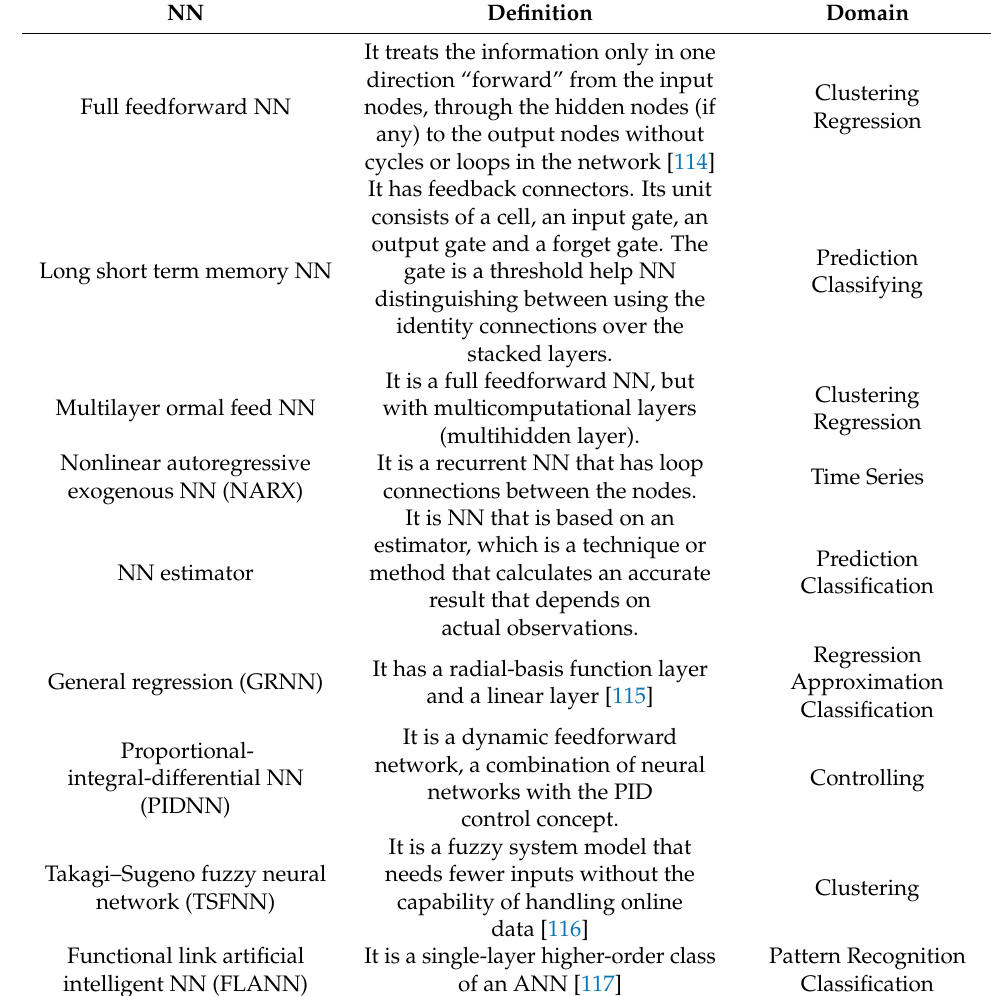
Table 4. Definition of neural networks used for modelling